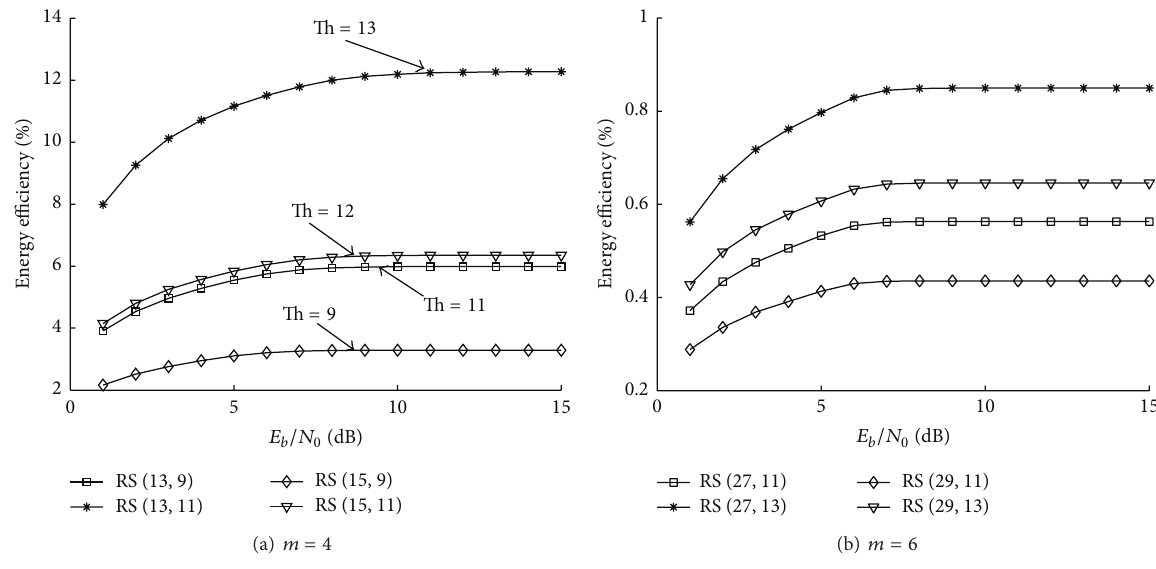
Figure 3: Analytical research of energy efficiency along with SNR.